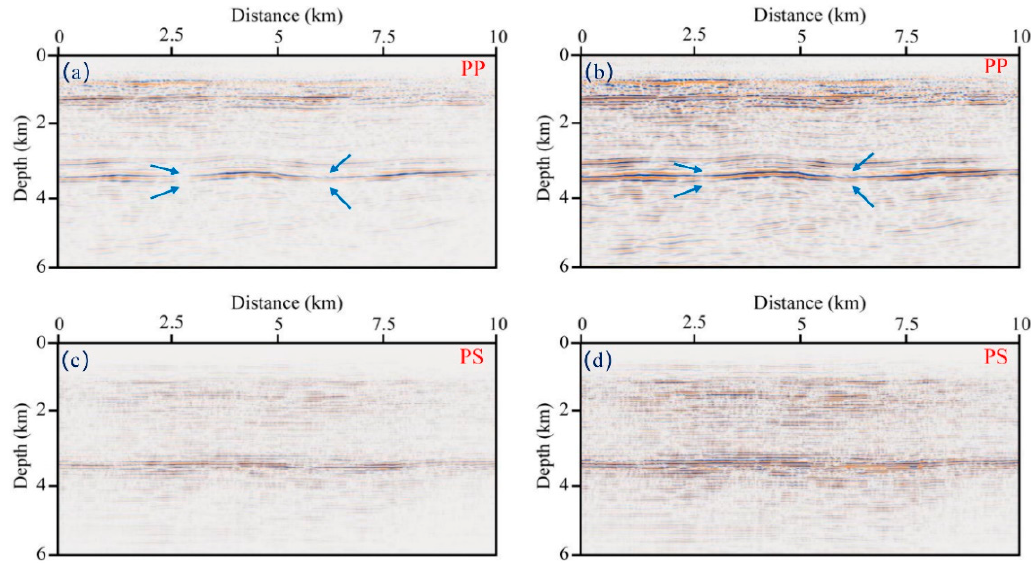
Figure 12. PP-images of the field data obtained by ( a ) ERTM method (without Q -compensation), ( b ) the proposed Q -ERTM scheme; PS − images of the field data obtained by ( c ) ERTM method (without Q -compensation), ( d ) the proposed Q -ERTM scheme.